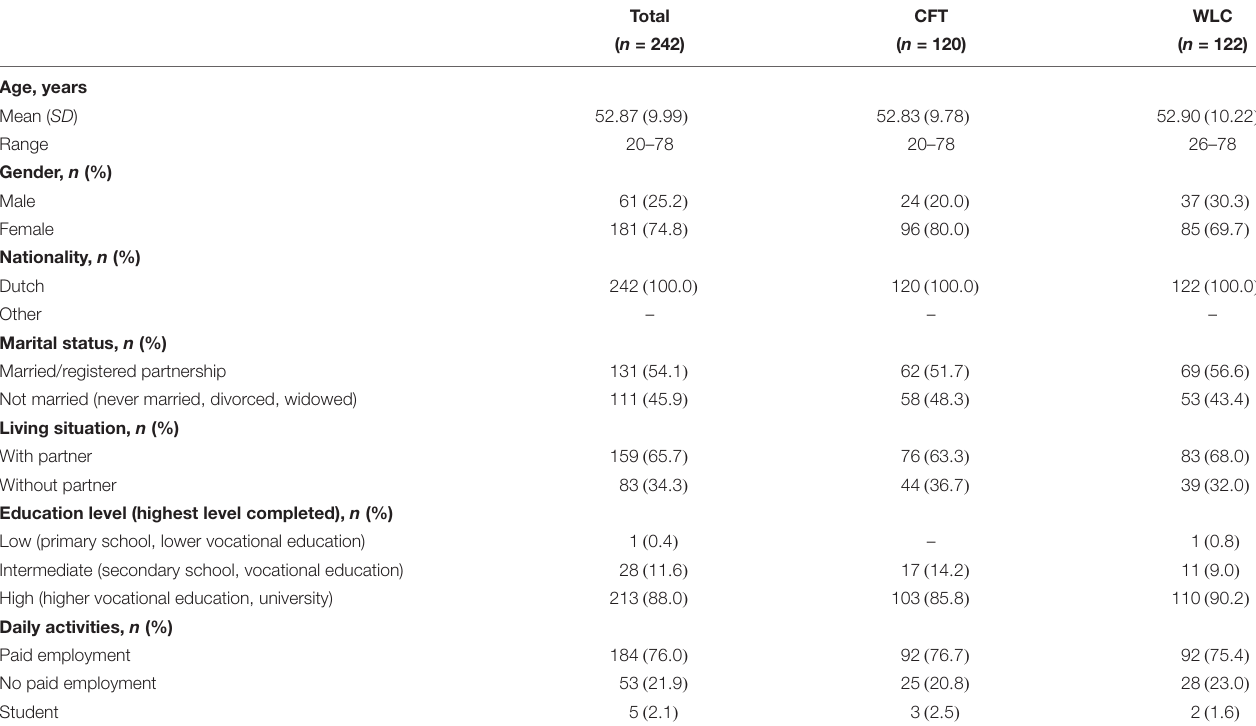
TABLE 1 | Baseline characteristics of the participants ( N =